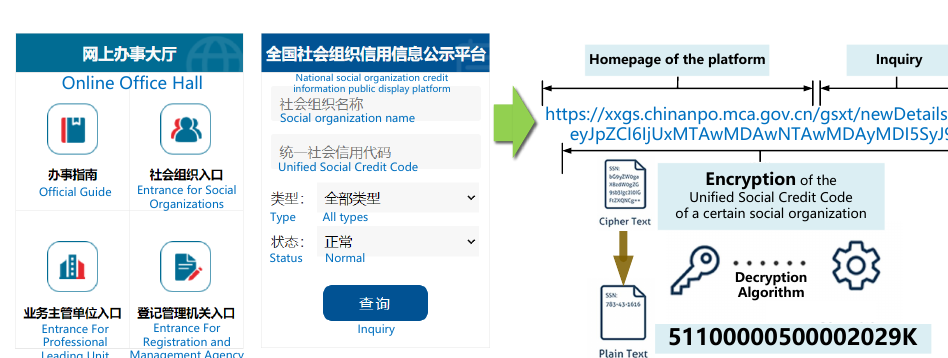
Figure 9. Composition rules and decryption of target